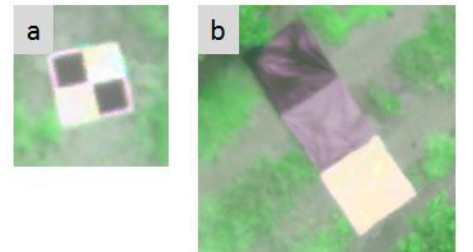
Figure 4. a) Targets for geometric correction, b) Targets for radiometric correction.